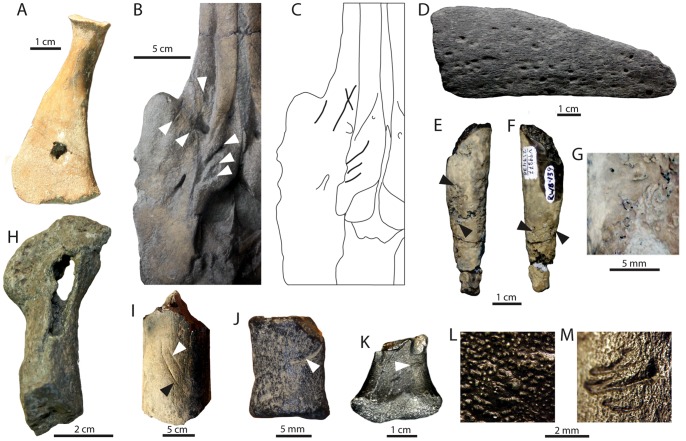
Examples of biogenic bone modifications encountered during this study.(A) fur seal radius (Pinnipedia: Otariidae, UCMP 219009) with mammalian bite marks (see Boessenecker and Perry, 2011). (B) Porpoise cranium (Odontoceti: Phocoenidae, undescribed genus; UCMP 219504) with two sets of linear bite marks (C). (D) Bone fragment (Mysticeti indeterminate; UCMP uncatalogued) with numerous circular pits. (E–F) Walrus tooth (Pinnipedia: Odobenidae: Dusignathinae; UCMP 219436) with irregular bioerosion tunnels; (G) magnified view of bioeroded surface. (H) Dolphin humerus (Odontoceti indeterminate; UCMP 219361) with bioeroded gallery. (I) Baleen whale mandible fragment (Mysticeti indeterminate; UCMP 219089) with parallel linear tooth marks. (J) Dolphin phalanx (Odontoceti indeterminate; UCMP 219627) with linear tooth mark. (K) Fur seal distal femur (Pinnipedia: Otariidae: Thalassoleon sp., cf. T. macnallyae; UCMP 219658) with gastric acid pitting (L) and linear scrape marks (M).